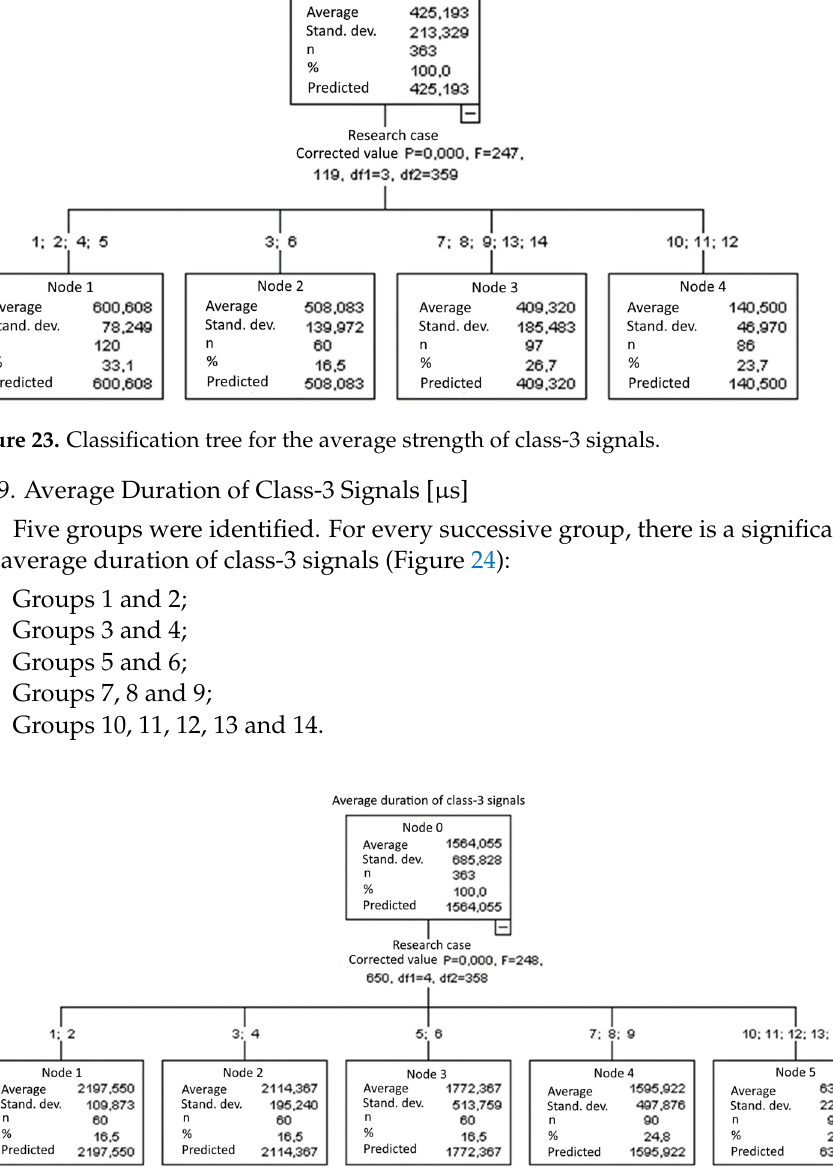
Figure 25. Classification tree for the number of class-4 signals. 3.2.11. Average Strength of Class-4 Signals [nVs] Four groups were identified. For every successive group, there is a significant drop in the average strength of class-4 signals (Figure 26): •